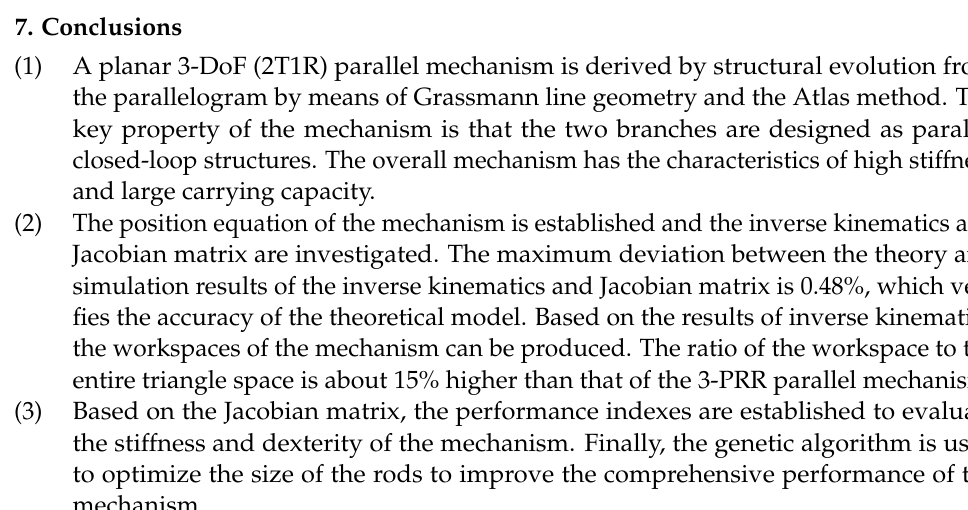
Figure 9. Convergence graph of best fitness